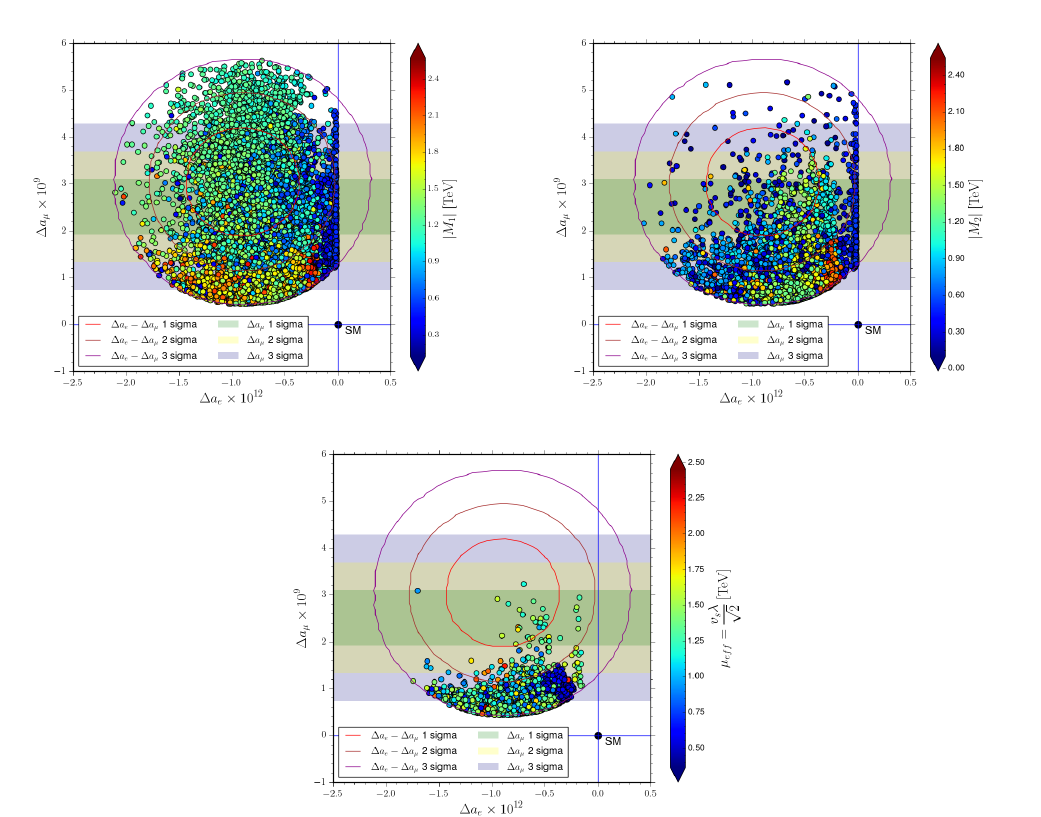
Figure 3 . Gaugino/higgsino mass parameters dependence on ∆ a µ and ∆ a e . We show solutions which pass all constraints, with masses indicated in the right-handed legends. Top left: bino- dominated solutions, Top right: wino-dominated solutions, Bottom: higgsino-dominated